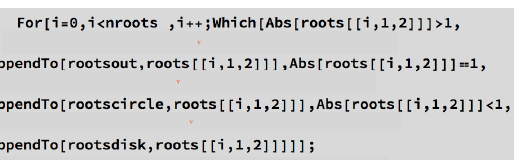
Figure 29. Part of the code structure of the [ARoots] algorithm code corresponding to the analysis of the absolute value of the roots of the inputed polynomial.